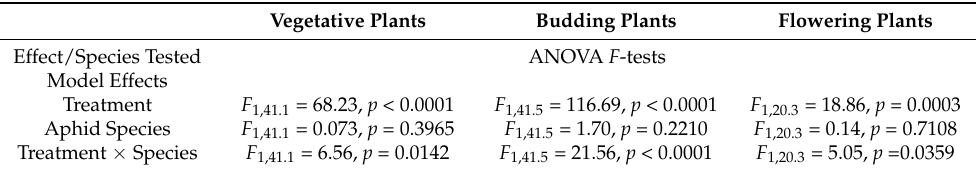
Table 2. Statistics for aphid-infested plants treated with A. aphidimyza or left untreated at different stages of plant growth of pansy ( Viola × wittrockiana Gams). Data were log( x + 1) transformed prior to